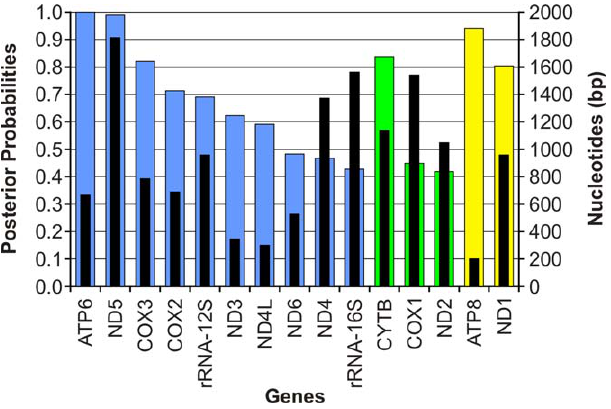
Figure 3. Gene-by-Gene Topology Colored bars indicate the posterior probabilities for each respective topology. Blue indicates a Mammuthus–Elephas sister group relationship, green indicates a Mammuthus–Loxodonta sister group relationship, and yellow indicates an Elephas–Loxodonta sister group relationship. Black bars show the length of the respective genes in base pairs.